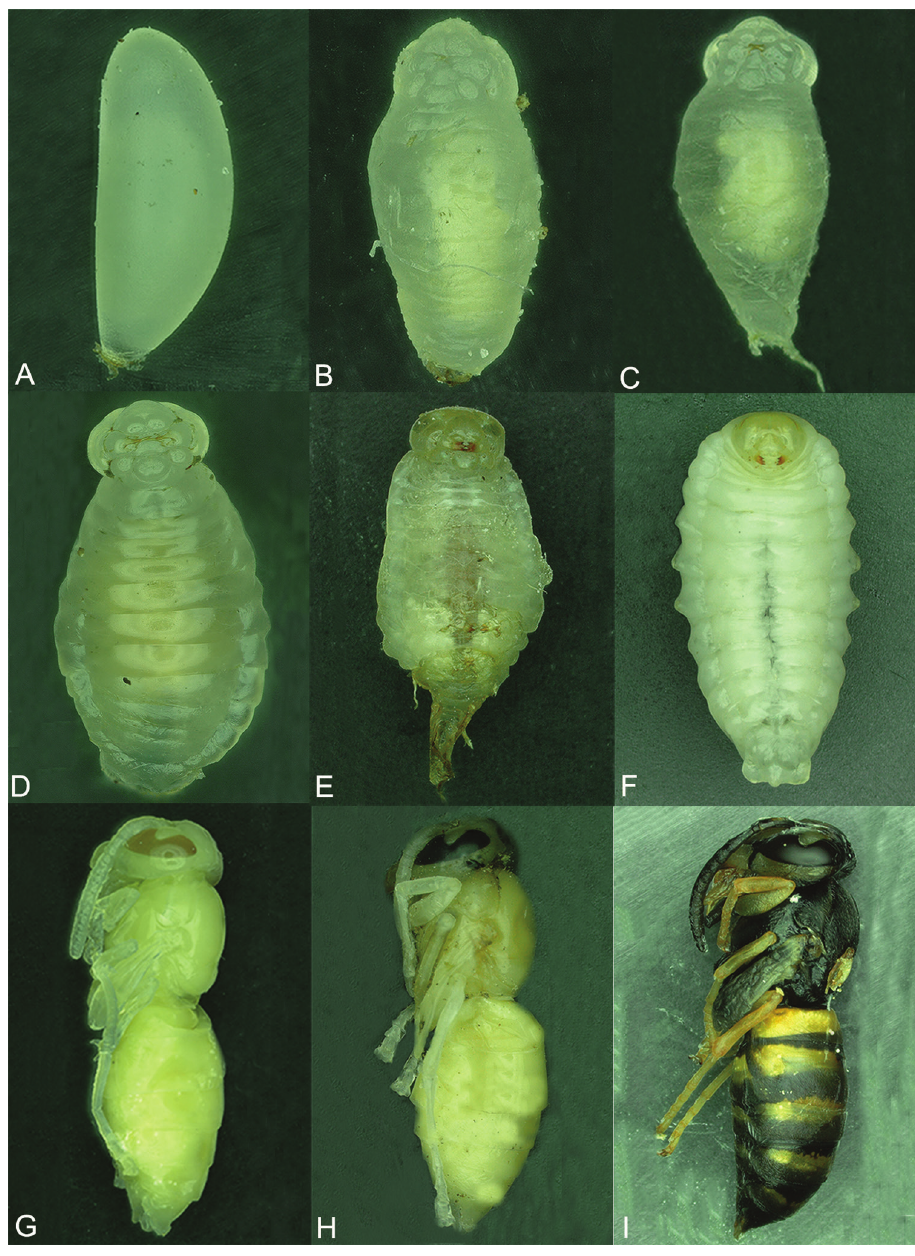
Figure 6. Vespula structor (Smith), immature stages. A–I Ventral view of immature stages. A Egg B first larvae instar C second instar D third instar E forth instar F fifth instar G, H pupa, lateral view I immature